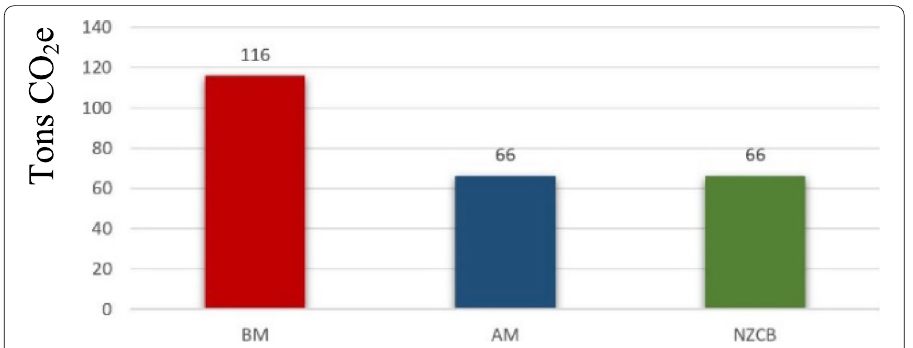
Fig. 14 Construction materials embodied CE for the three